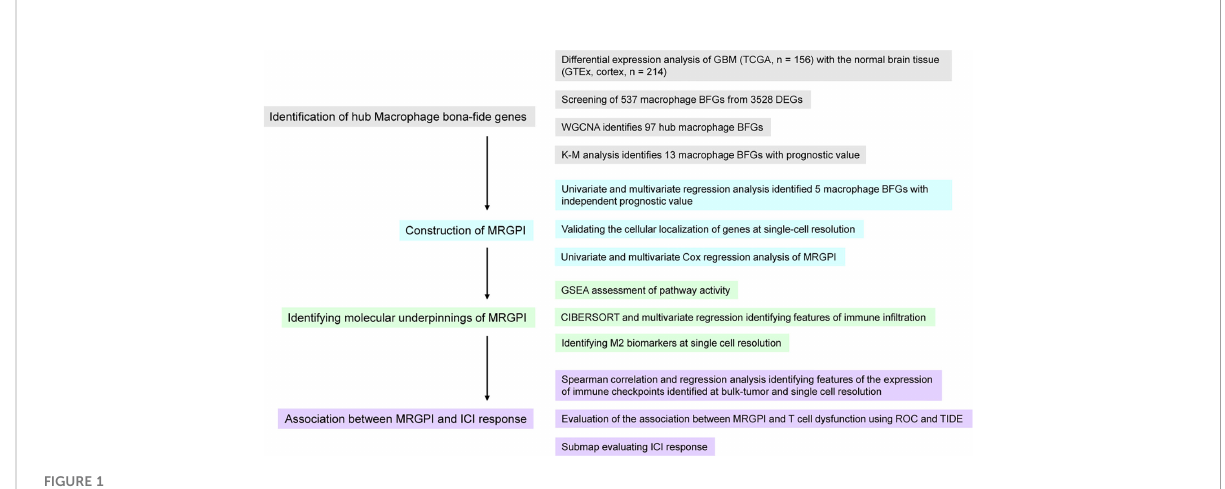
FIGURE 1 Overview of the work fl ow of this